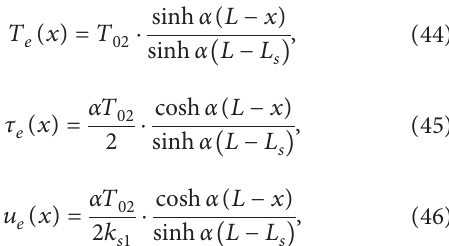
Figure 14: Effect of the interface frictional resistance at stage I on Et .